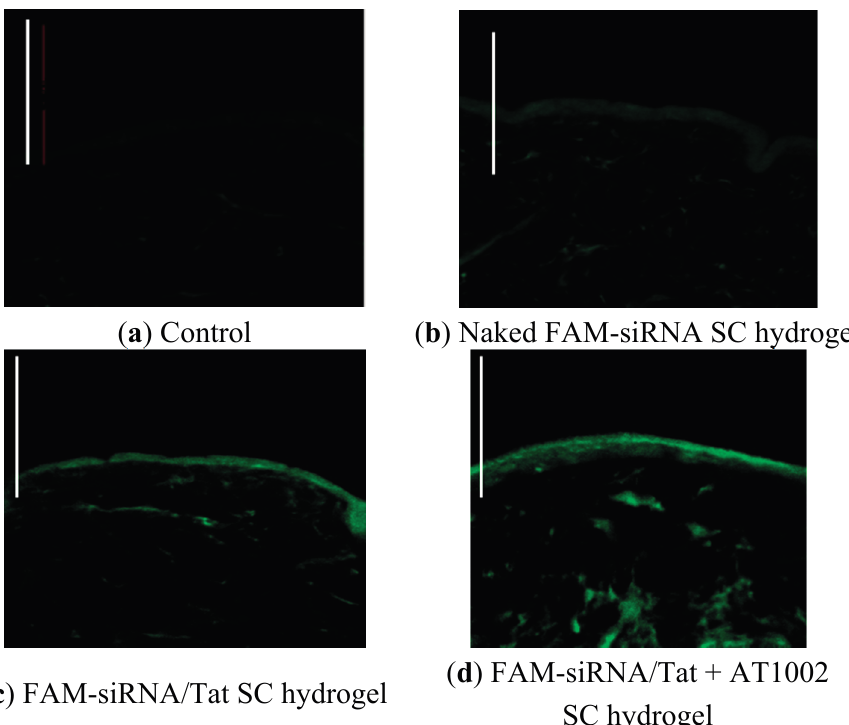
Figure 1. Intradermal distribution of FAM-siRNA in tape-stripped back skin of